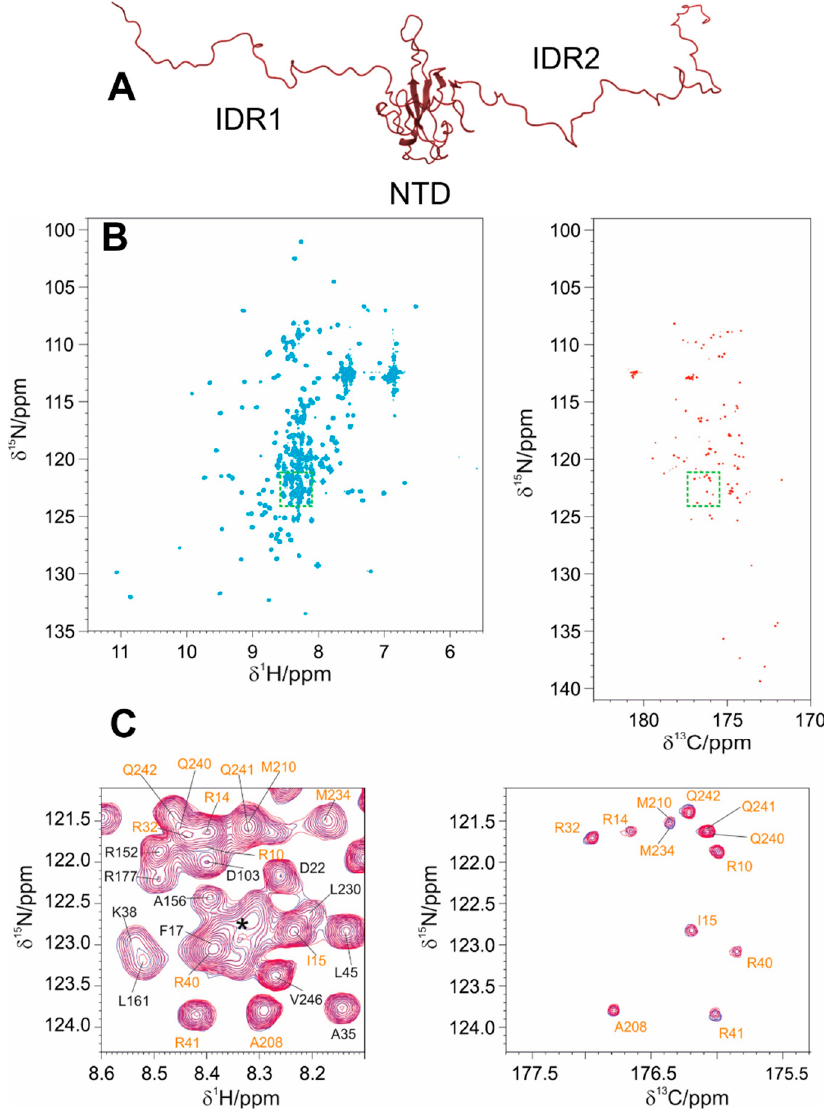
Figure 8. The picture reports the results of the mr_CON/HN [42] experiment (Panels B , C ) performed on the NTR construct (Panel A ). The 2D HN spectrum is reported on the left in panel B; the 2D-CON spectrum is reported on the right in the same panel. Panel C shows a zoom of the superimposed spectra (HN in the left and CON on the right) acquired through the multiple receiver approach in the absence (blue) and with the addition of 0.1 equivalents of EP (magenta). These two regions are highlighted by green boxes in panel B. The CON provides superior resolution with respect to the HN one, which provides a higher number of signals, complicating the analysis.